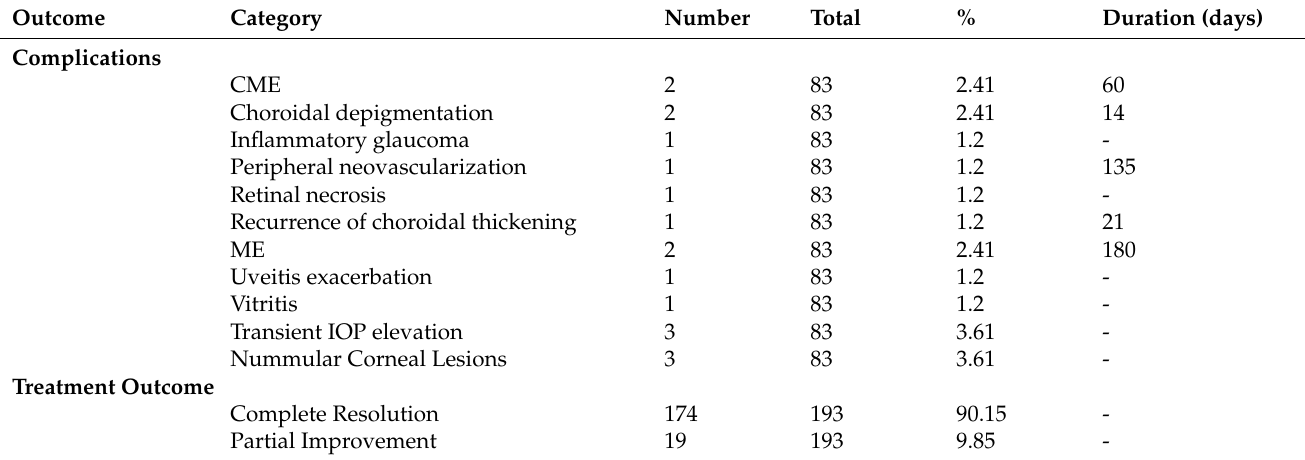
Table 6. The outcomes and complications following the treatment of vaccine-associated